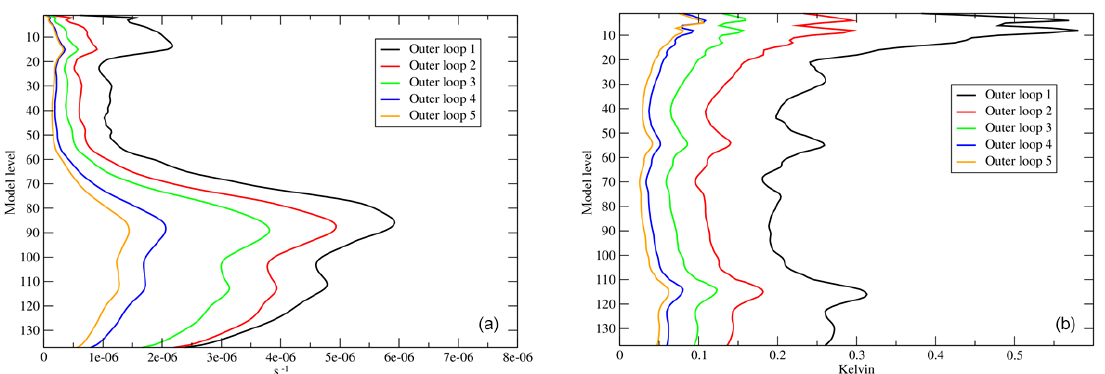
Figure 6. Vertical profiles of the globally averaged standard deviation of the analysis increments produced by successive outer loop iterations for vorticity (a) and temperature (b) . Values have been averaged over a 1-month period. The assimilation experiment has been run with an outer loop resolution corresponding to a cubic octahedral reduced Gaussian grid with spectral truncation 399 (TCo399, approx. 30km grid spacing), and inner loop resolutions corresponding to linear reduced resolution Gaussian grids at spectral truncations TL95/159/255/255/255, corresponding to approx. 210 / 120 / 80km grid